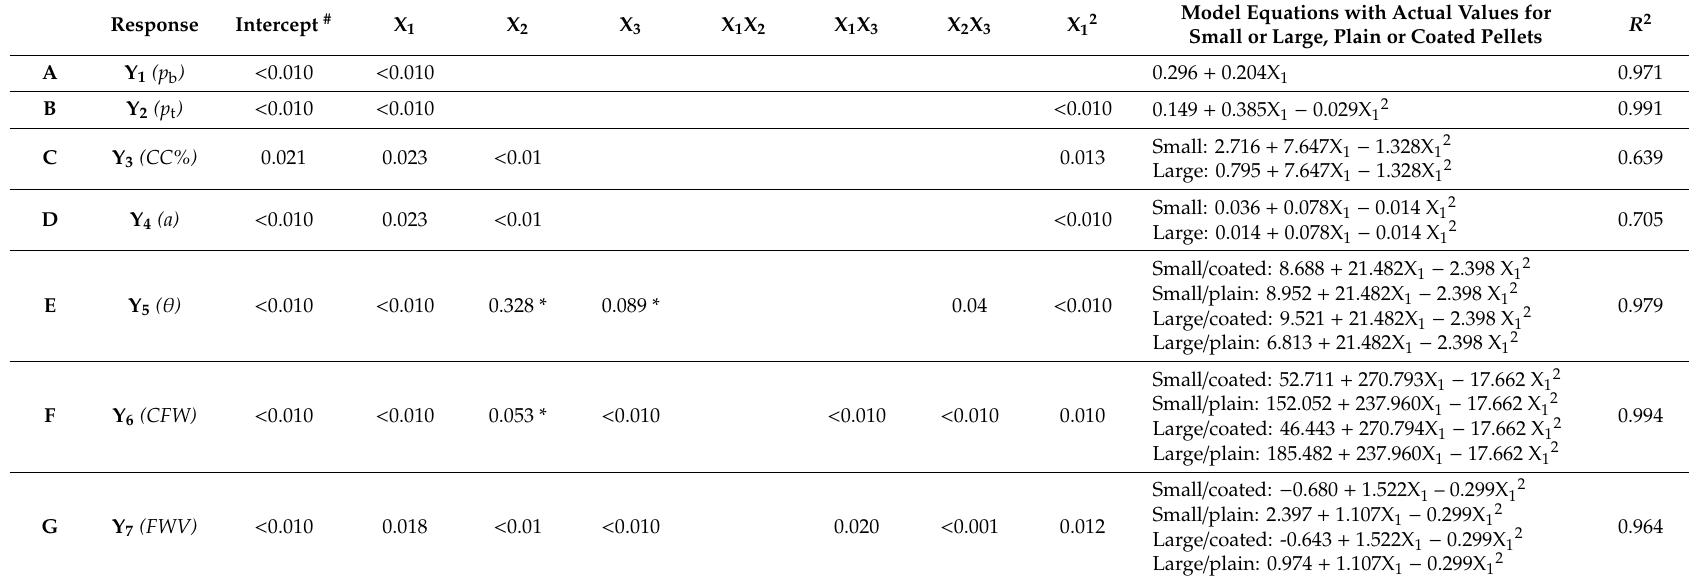
Table 4. MLR—Significant terms ( p values) and computed MLR models with index of the goodness of fitting (R 2